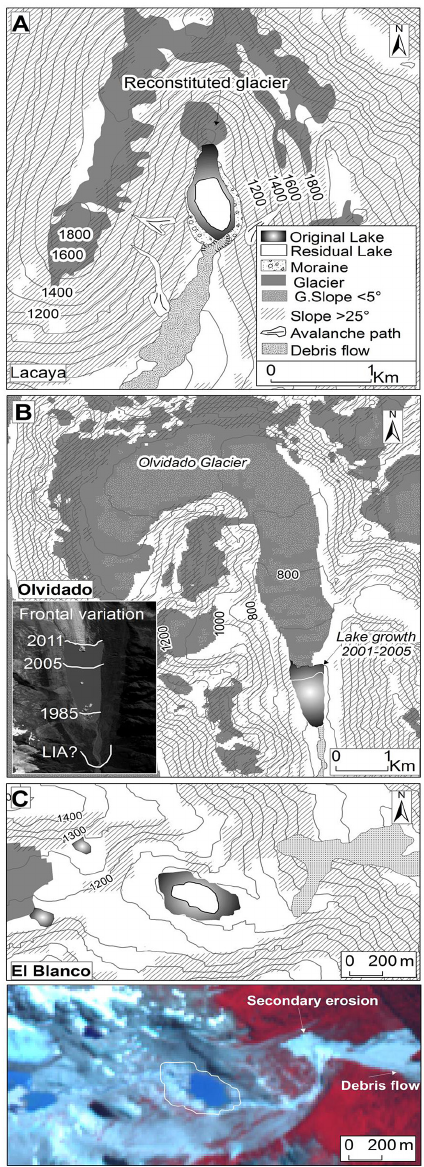
Figure 9. Settings of moraine-dams failed in Patagonia; (a) lake in the head of a catchment at the toe of a reconstituted glacier, (b) growing lake in contact with a retreating glacier and (c) lake distant from the glacier tongue. Note the steep slopes and glaciers surrounding the